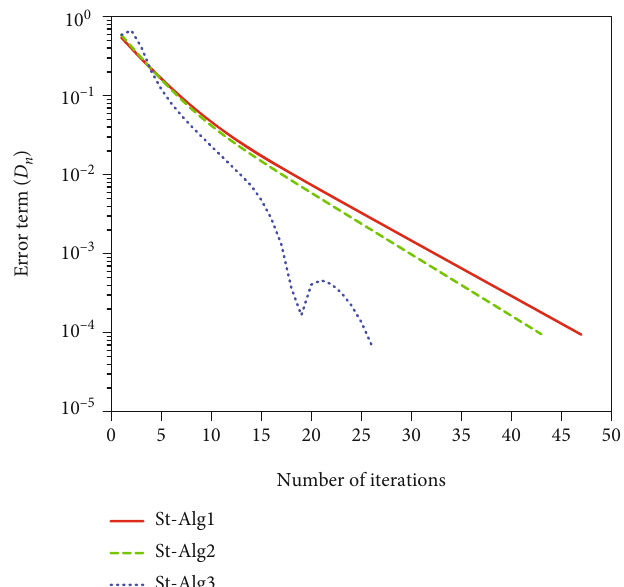
Figure 4: Numerical computational behavior of Algorithm 1:, Algorithm 2:, and Algorithm (4.2) while κ